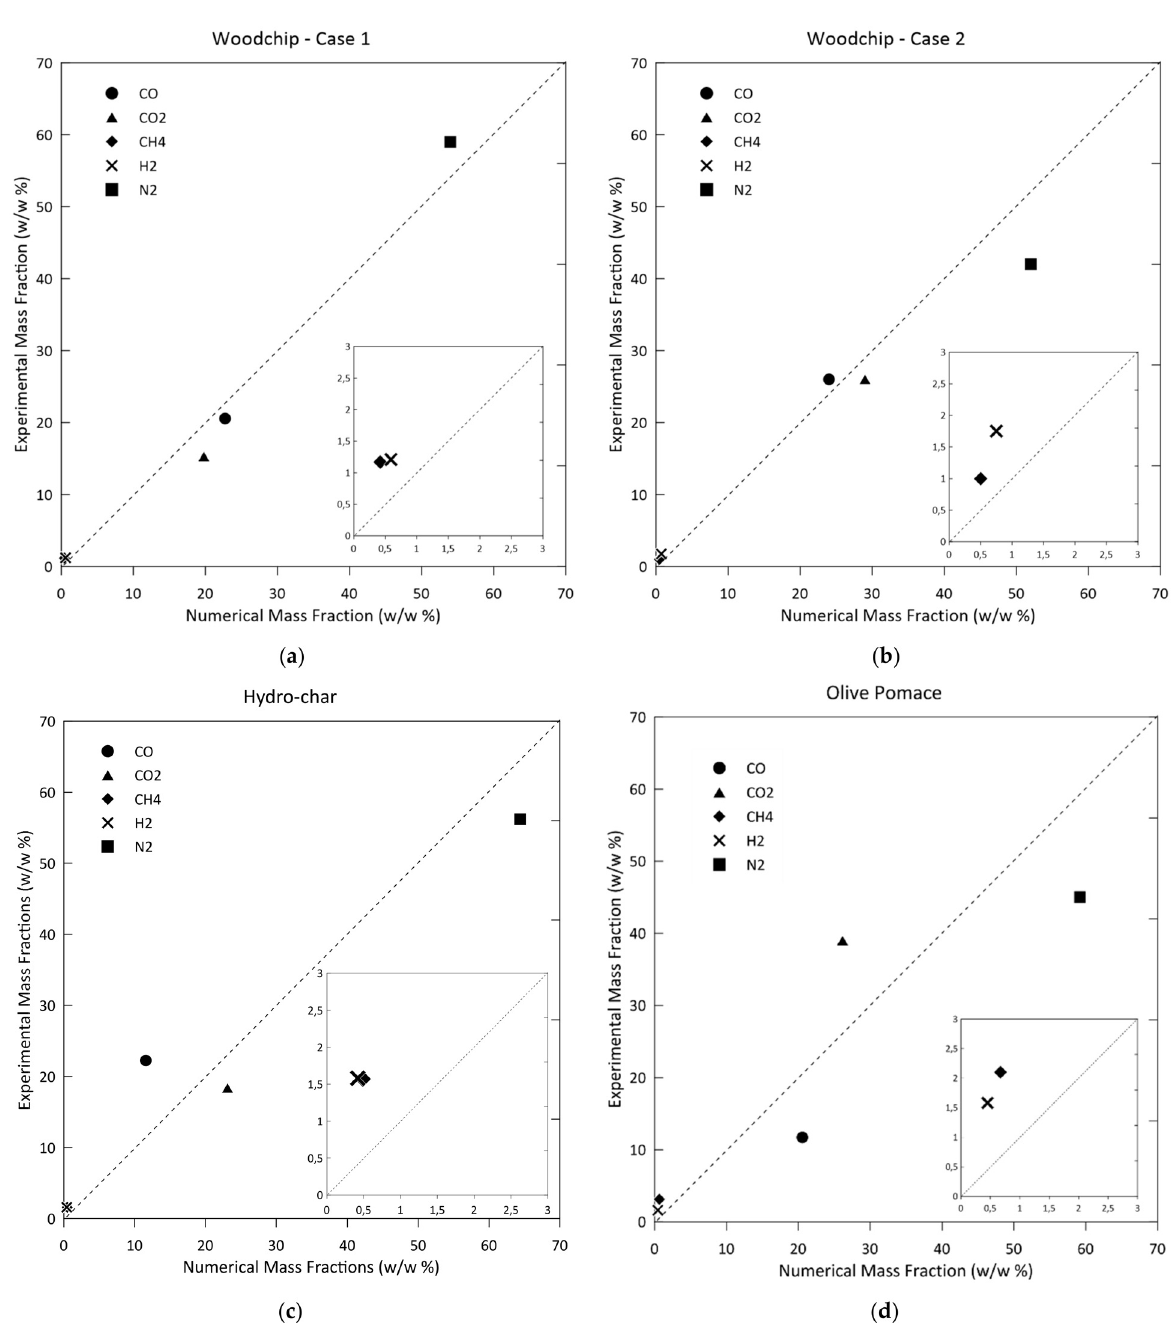
Figure 7. Linear adjustment comparison between the measured and numerical syngas species (on a dry tar-free basis) for the four biomasses tested: ( a ) woodchip case 1, ( b ) woodchip case 2, ( c ) hydro-char from green waste, ( d ) olive